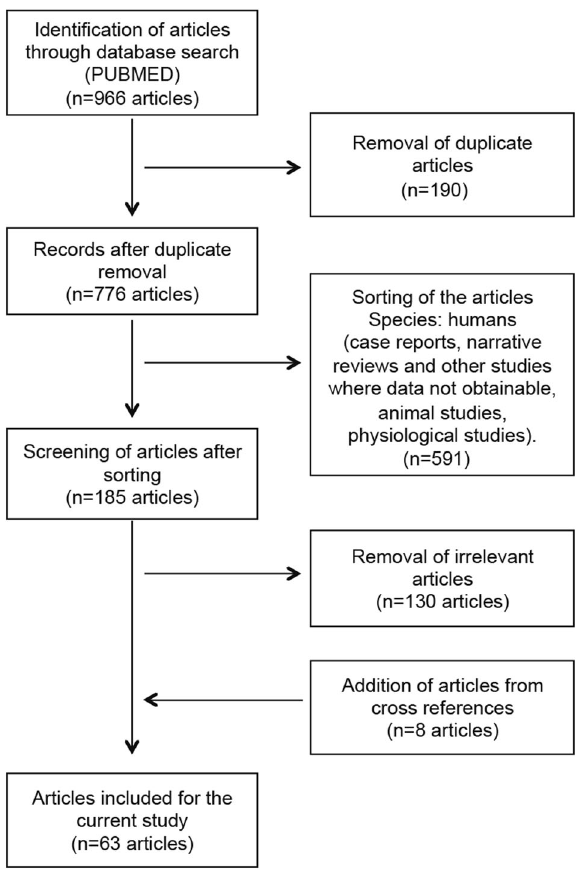
Fig. 7 Study selection criteria to determine the population of microbes present in atherosclerotic plaques of CAD patients. Cataloguing procedure used to annotate all known oral microbes that have been identi fi ed from atherosclerotic plaque samples of CAD patients. In brief, the records present in PUBMED were studied by using combination of terminologies such as microbes, micro- organism, and bacteria along with CAD, cardiovascular disease, atheroma, atherosclerosis, and atherosclerotic plaque. The articles were collated, duplicates removed, and relevant data